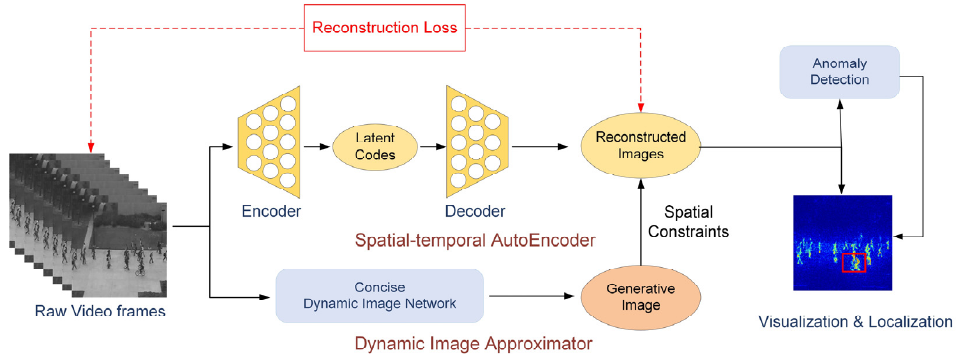
Figure 1. The process of video anomaly detection. The detection process is obtained through the spatiotemporal autoencoder and the dynamic image approximator. The regularity score detects the abnormal event. Then the model is explained by the straightforward visual perturbation method.